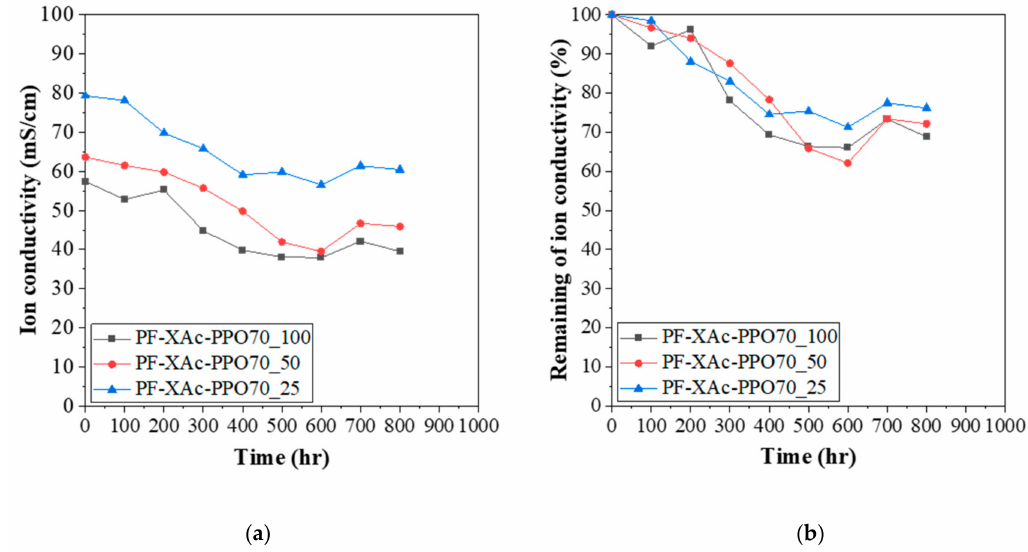
Figure 8. ( a ) The hydroxide conductivity (80 ◦ C) and ( b ) the remaining of conductivity of crosslinked pore-filling membrane during immersion in aqueous 1M KOH at 60 ◦ C.